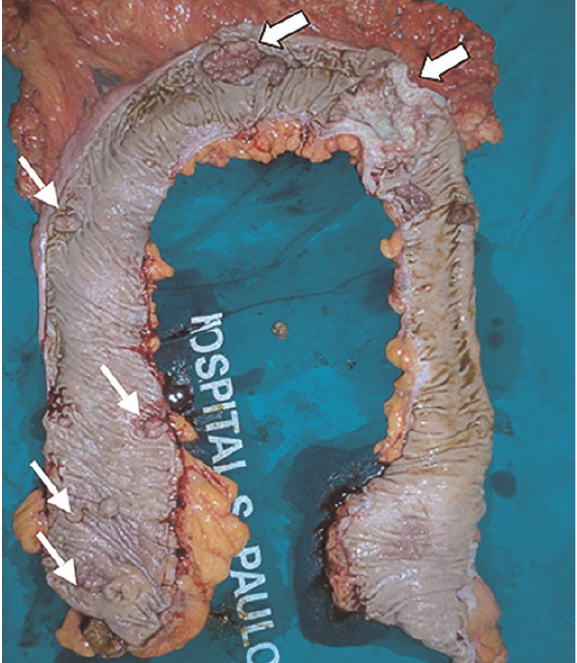
Figure 2 - Macroscopic evaluation of the total colectomy product from the same patient as shown in Figure 1, a surgical specimen with synchronous tumors (large arrows) and several scattered polyps (thin